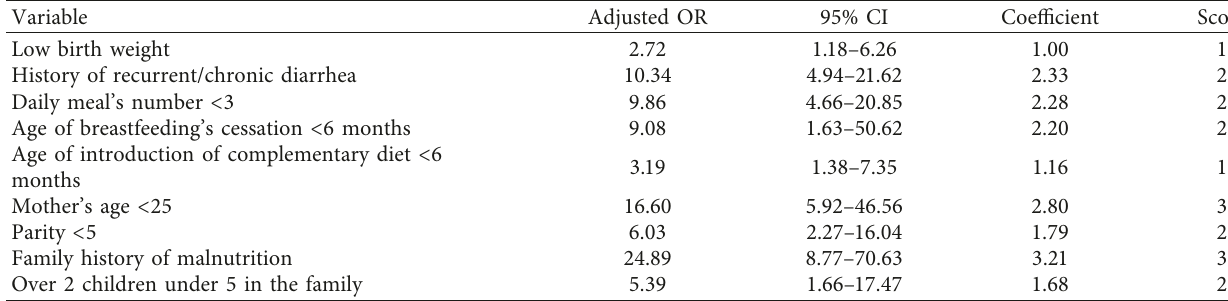
Table 2: Logistic regression model of risk of